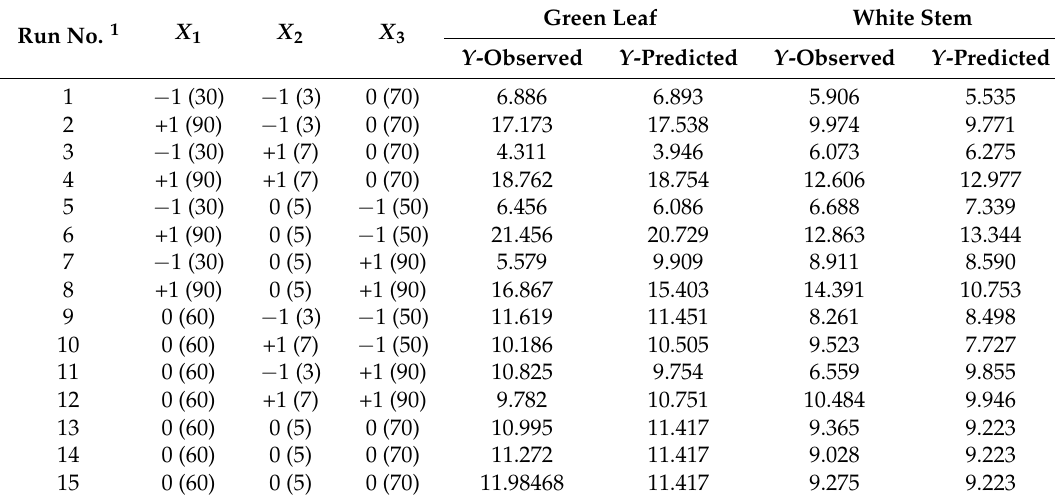
Table 1. Independent variables, their coded (actual) levels and the corresponding observed and predicted